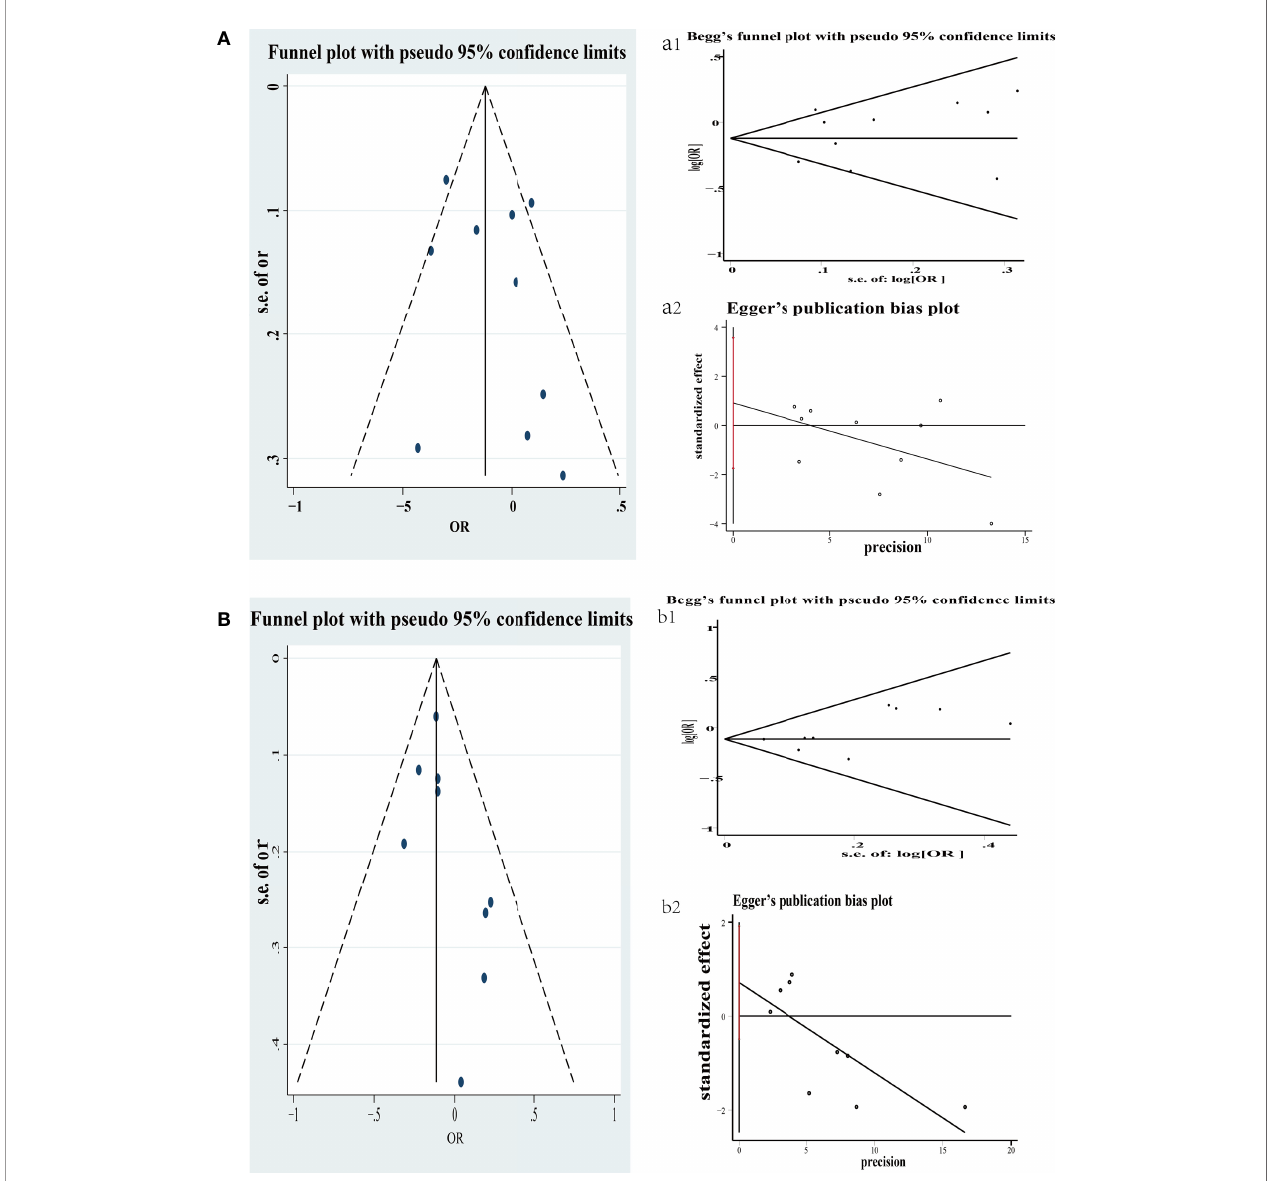
FIGURE 4 | Funnel plot of colorectal cancer risk associated with consumption of yogurt in case – control (A) ; Begg ’ s and Egger ’ s funnel plot for publication bias test on consumption of yogurt in case – control (a1 and a2). Each point represents a separate study for the indicated association. s.e., standardized effect. Funnel plot of colorectal cancer risk associated with consumption of cheese in case – control (B) ; Begg ’ s and Egger ’ s funnel plot for publication bias test on consumption of cheese in case – control (b1 and b2). Each point represents a separate study for the indicated association. s.e., standardized